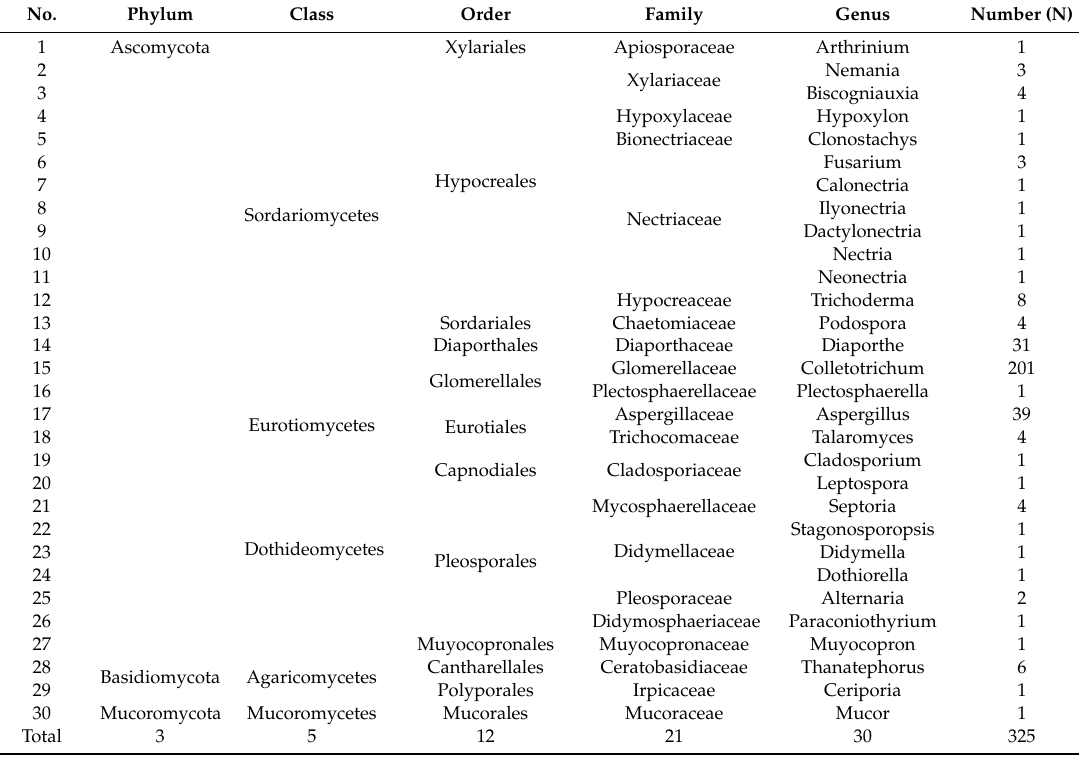
Table 2. Taxa of all endophytic fungi isolates from C. japonicus